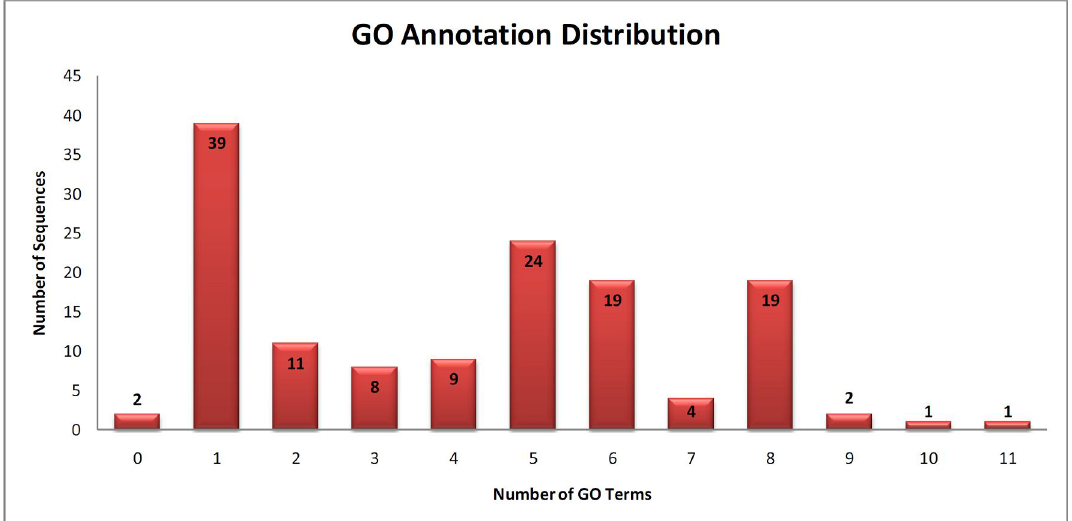
Figure S5: Distribution of the number of GO terms (Cellular Component, Molecular Function and Biological Process) from the 140 EST-Contigs analyzed by